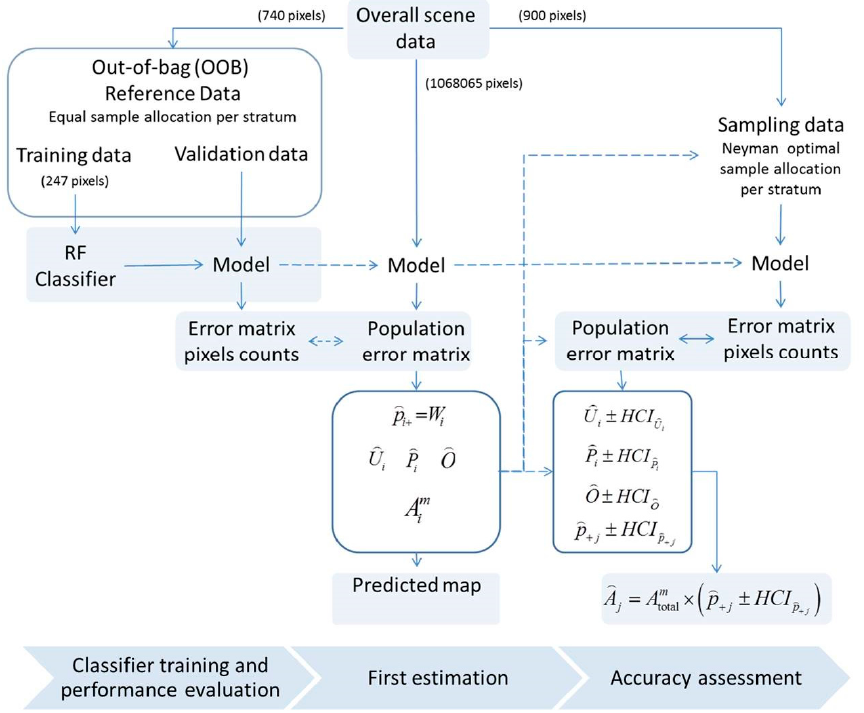
Figure 4. Methodological framework, the workflow of data processing, and accuracy assessment. The accuracy assessment could be done for proportional, power, equal or Neyman optimal allocation of samples in each stratum in accord with the sampling design. Table 2. The equation used to estimate error matrix, population error matrix, user accuracy, producer accuracy and overall accuracy